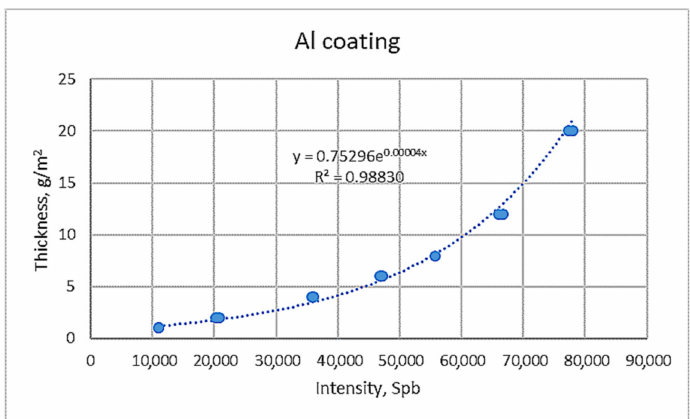
Figure 4. Calibration curve used to determine unknown Al coating thicknesses from the XRF intensity of the Al line.